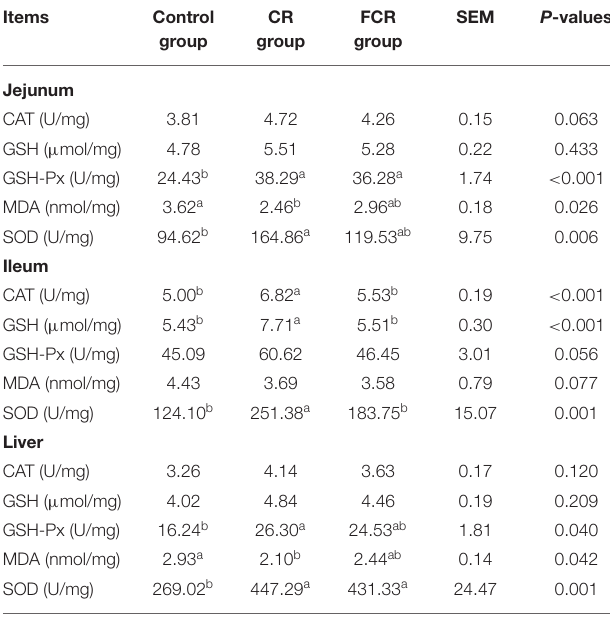
TABLE 2 | Effects of cassava residue (CR) or fermented cassava residue (FCR) on intestinal and hepatic antioxidant capacity of piglets.